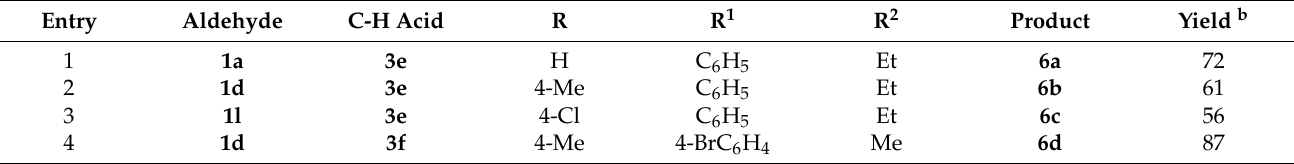
Table 2. Multicomponent synthesis of (2 SR ,3 RS ,4 SR ,6 RS )-2-hydroxypiperidines 6 a .